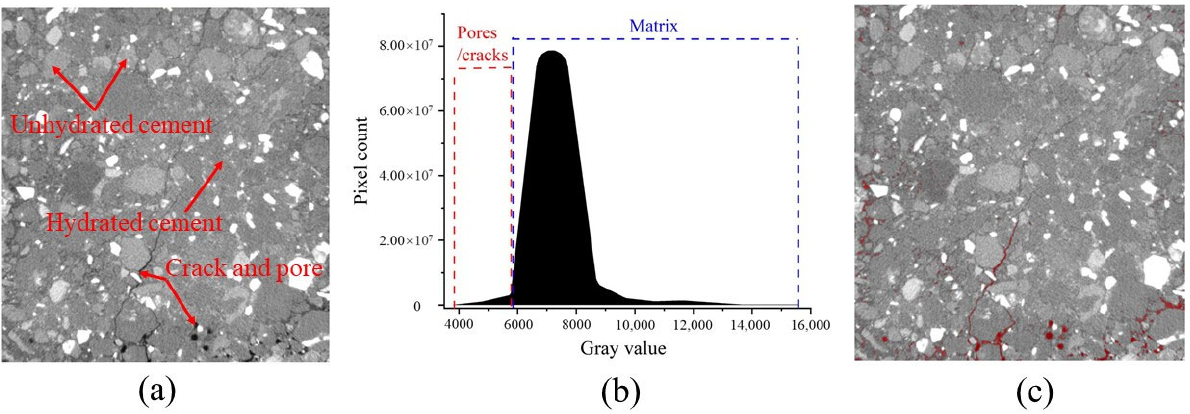
Figure 4. Distinction between the cement matrix and cracks (pores): ( a ) original picture; ( b ) gray value distribution; ( c ) distribution of cracks (pores; marked by